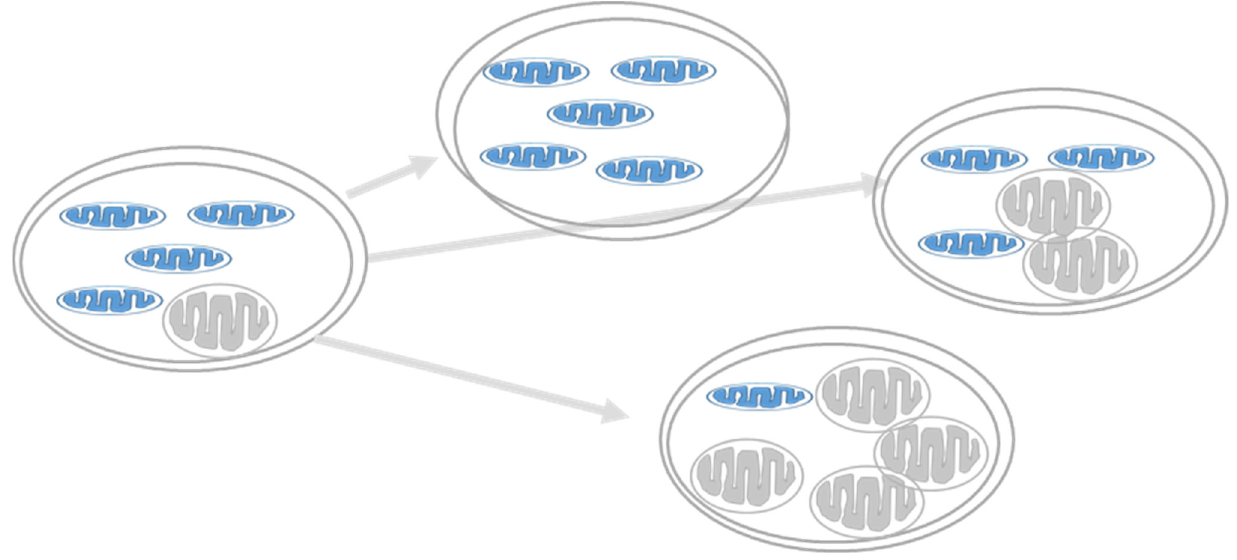
Figure 6. Heteroplasmy and diabetes. Heteropalsmy is the relative proportion of mtDNA copies carrying the mutation in a specific tissue. A specific phenotype develops when a certain threshold level of mutation is reached (usually ~60%) [55].